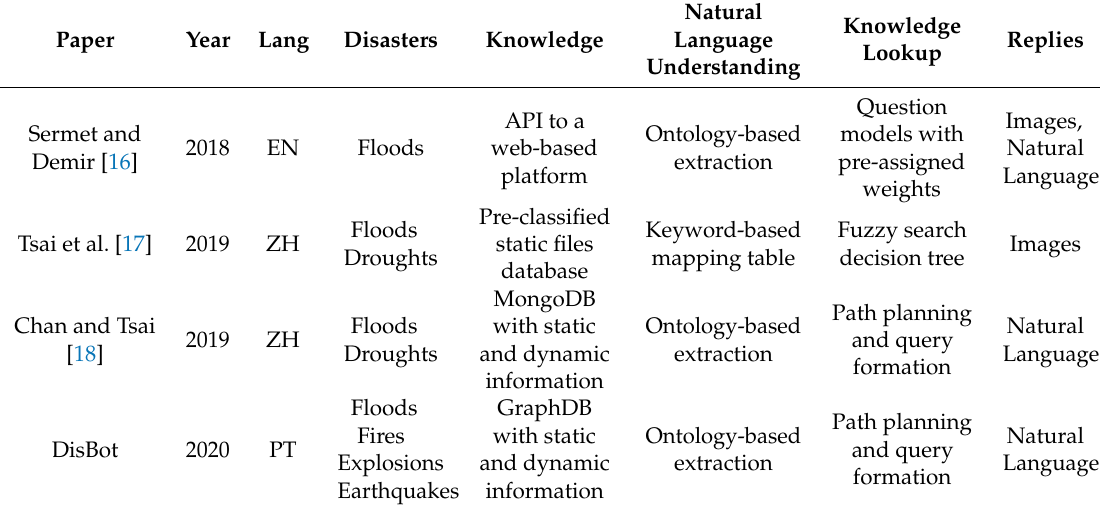
Table 3. Summary of the systems included in the systematic